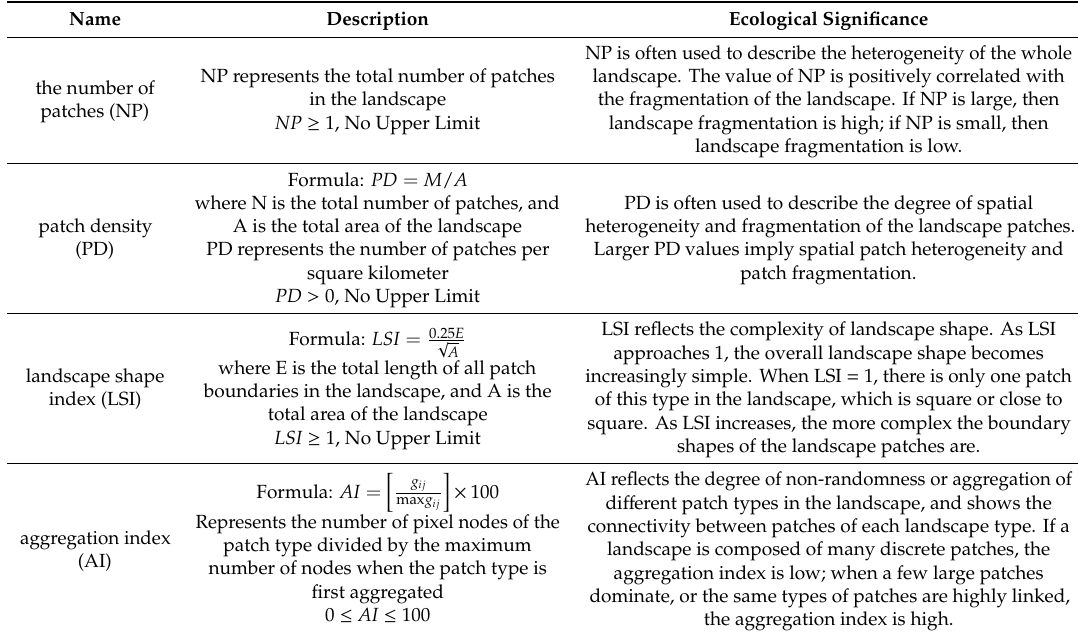
Table 4. Definition and ecological significance of each landscape